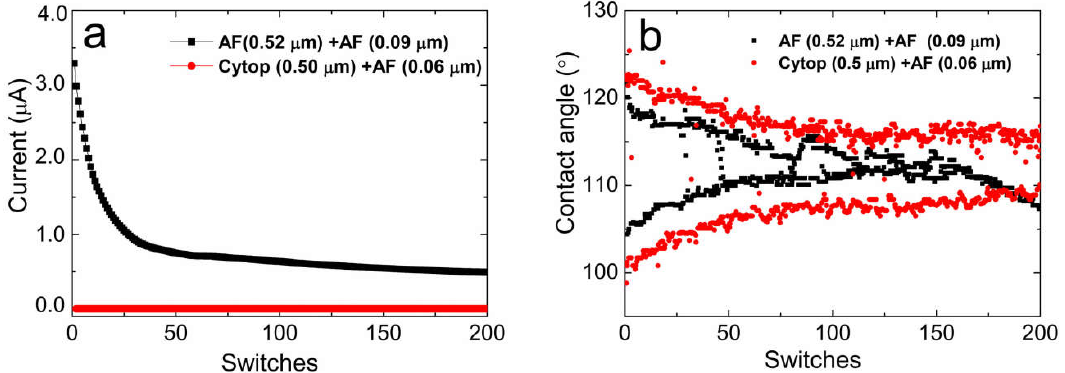
Figure 9. Leakage current and electrowetting reduction of bilayer fluoropolymer coatings with ( a ) 0.52 µ m Teflon AF as the bottom layer and 0.09 µ m Teflon AF as the top layer, and ( b ) 0.5 µ m Cytop as the bottom layer and 0.06 µ m AF as the top layer.